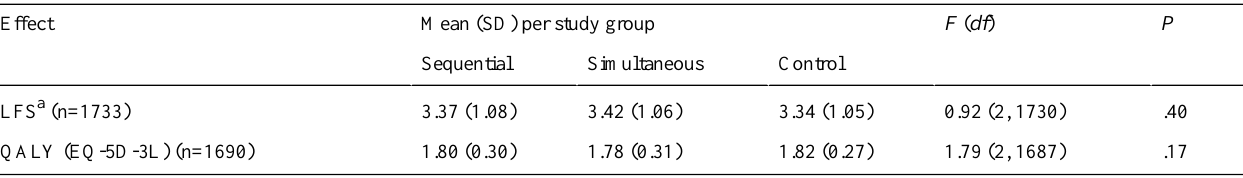
Table 3. Mean biennial effect on the lifestyle factor score (LFS) and quality-adjusted life year (QALY) score per participant per study